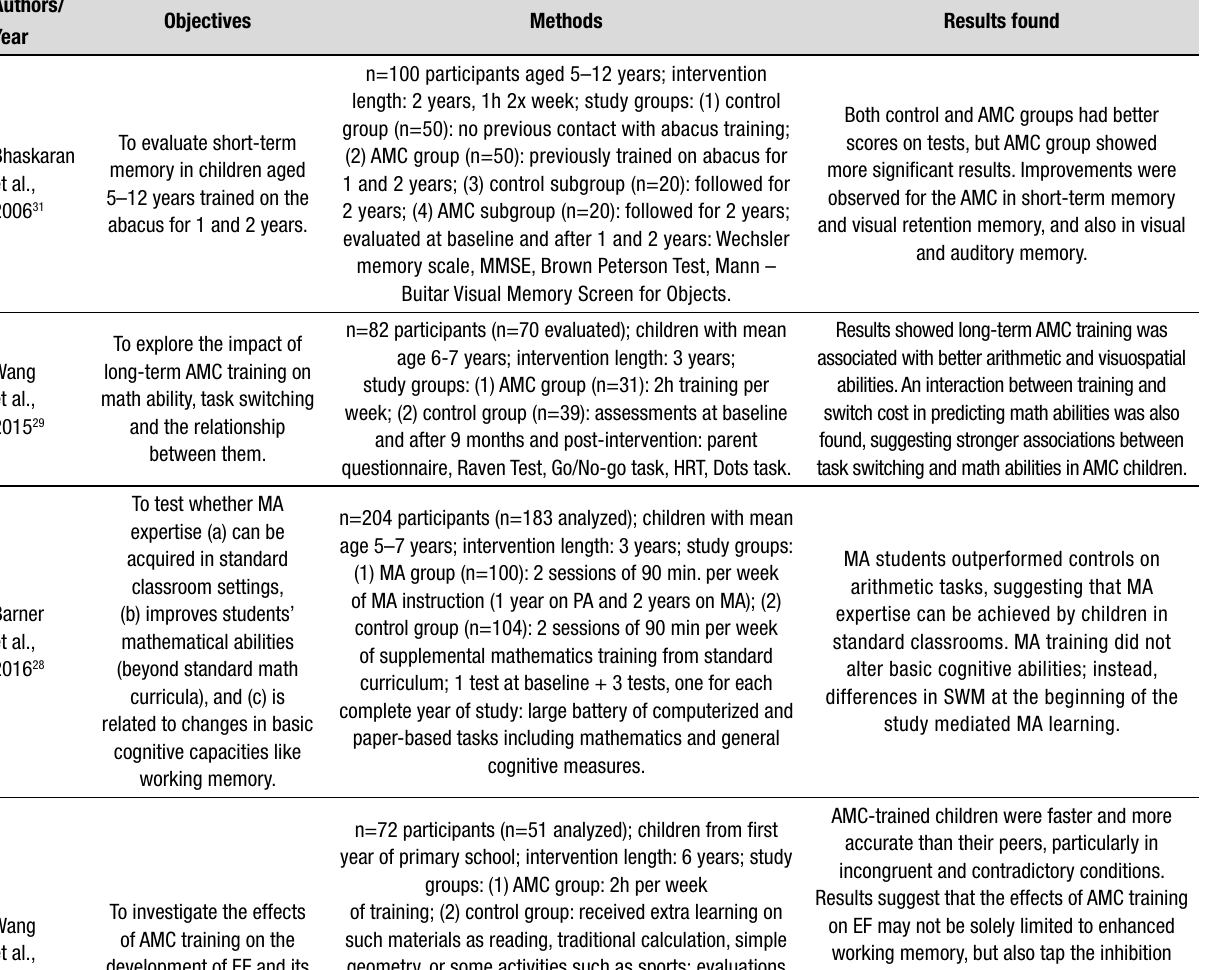
Table 1. Studies using abacus as a tool in cognitive training